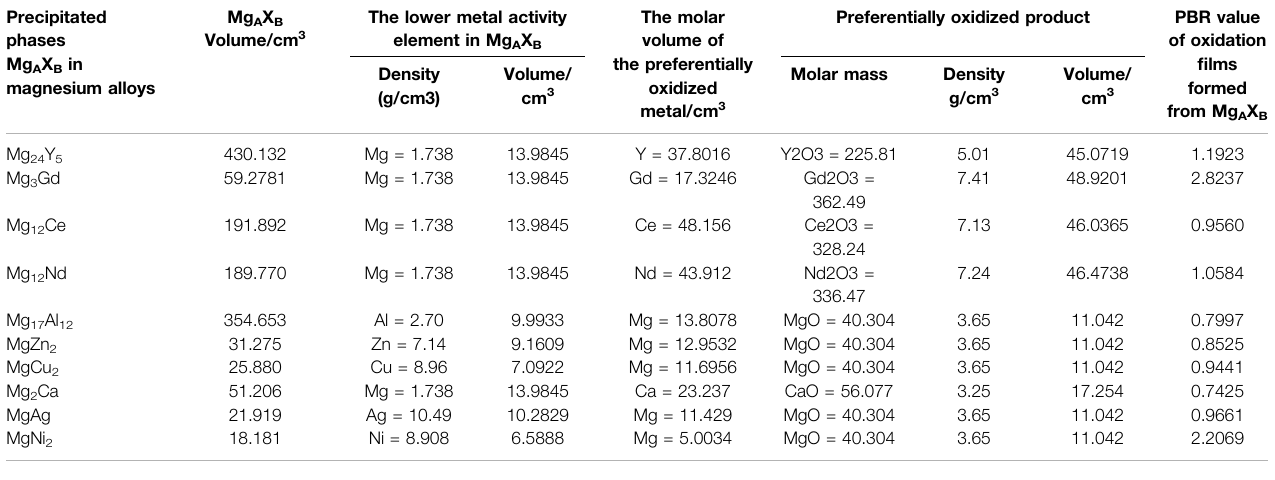
TABLE 3 | PBR value of the oxide fi lm formed from the precipitated phases of magnesium alloys. Precipitated phases